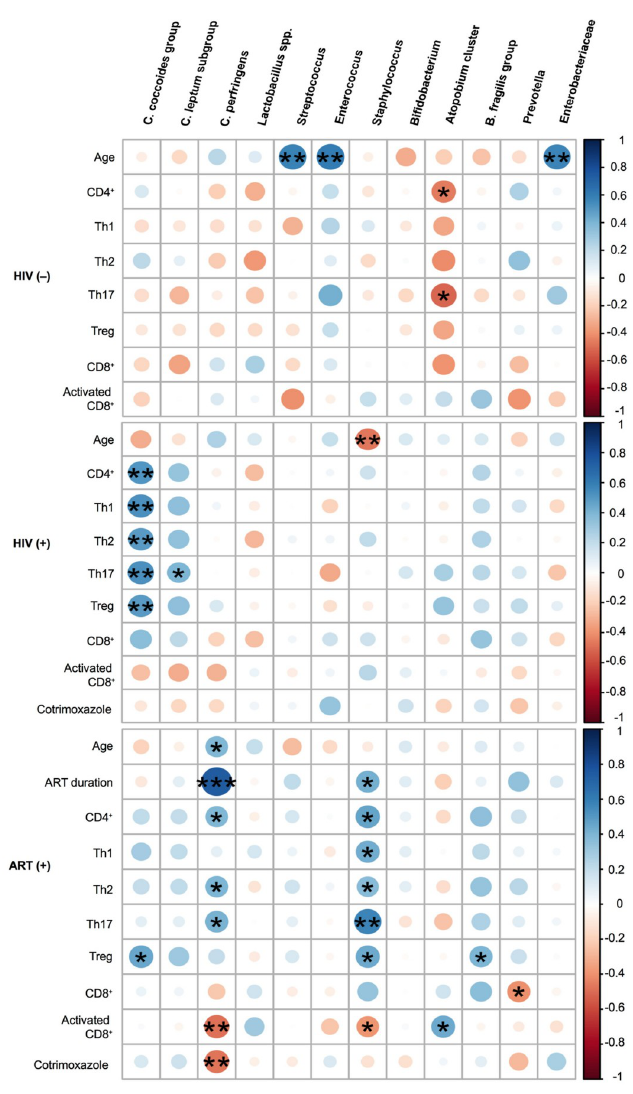
Fig 3. Heatmap representing the correlation of gut microbiota with age, anti-retroviral therapy (ART) duration, immune status, and use of cotrimoxazole. Blue shading indicates a positive association and red shading a negative association. The scale indicates the strengths of associations. C . difficile and Pseudomonas were not included due to the low detection frequencies (3.4% to 20% in all three groups: C . difficile , median = log 10 1.15 cells/g feces, and Pseudomonas , median = log 10 1.45 cells/g feces, S2 Table). The color intensity and size of the circles are proportional to the correlation coefficients. � P < 0.05, �� P < 0.01, ��� P < 0.001, based on Spearman’s rank-test.